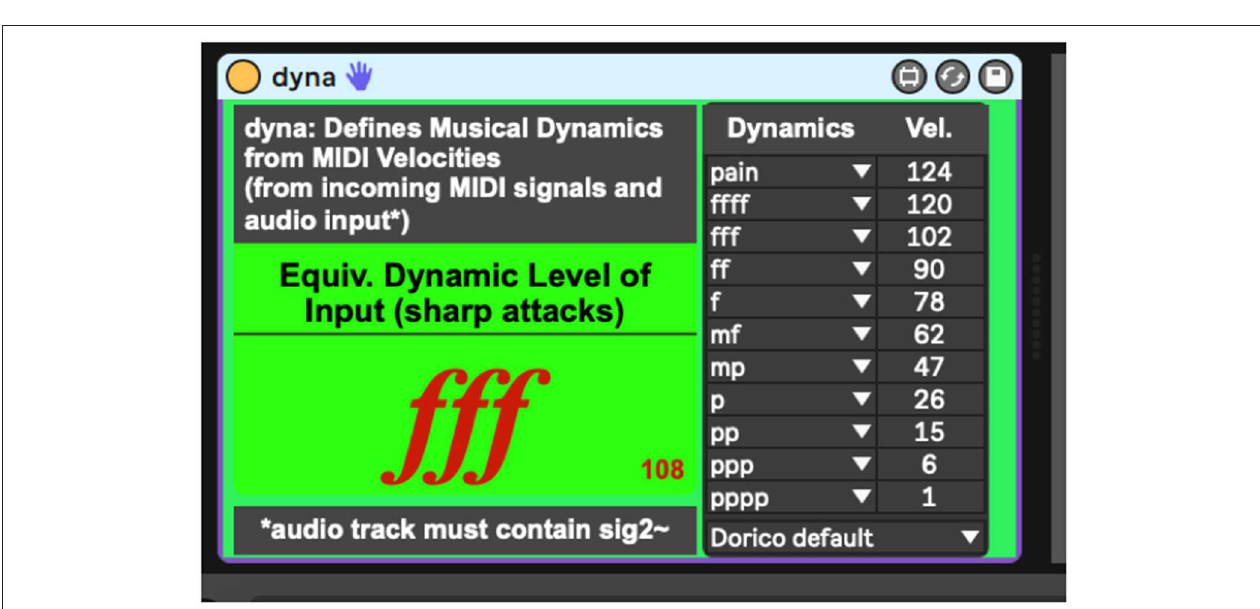
through ( Figure 7 ). This process begins automatically once the device is loaded but can be manually reset if need be. As a human listener ignores the ambient hum of an air conditioning unit while trying to listen to live music, this system works best if the performer remains as quiet as possible during this setup